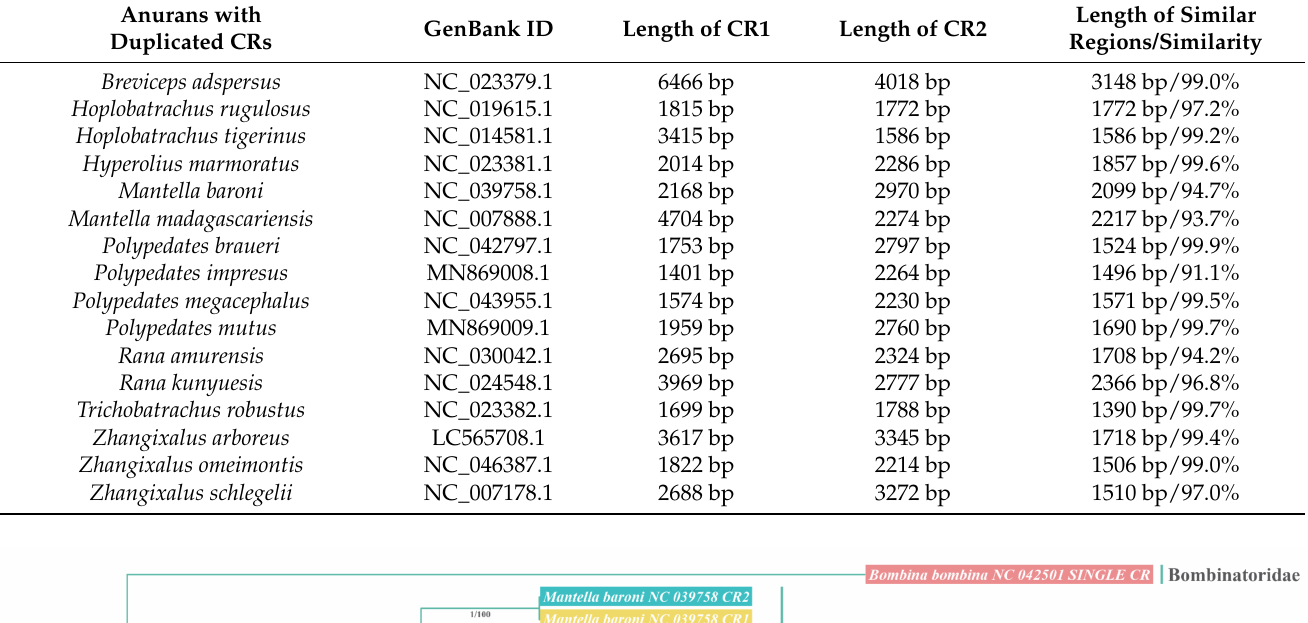
Table 3. Mitogenome control region (CR) sequence similarity of 16 anurans from NCBI RefSeq database with duplicated CRs.